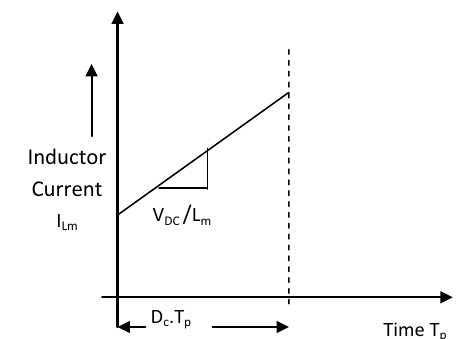
Fig. 5 Inductor current I Lm during interval D c .T p